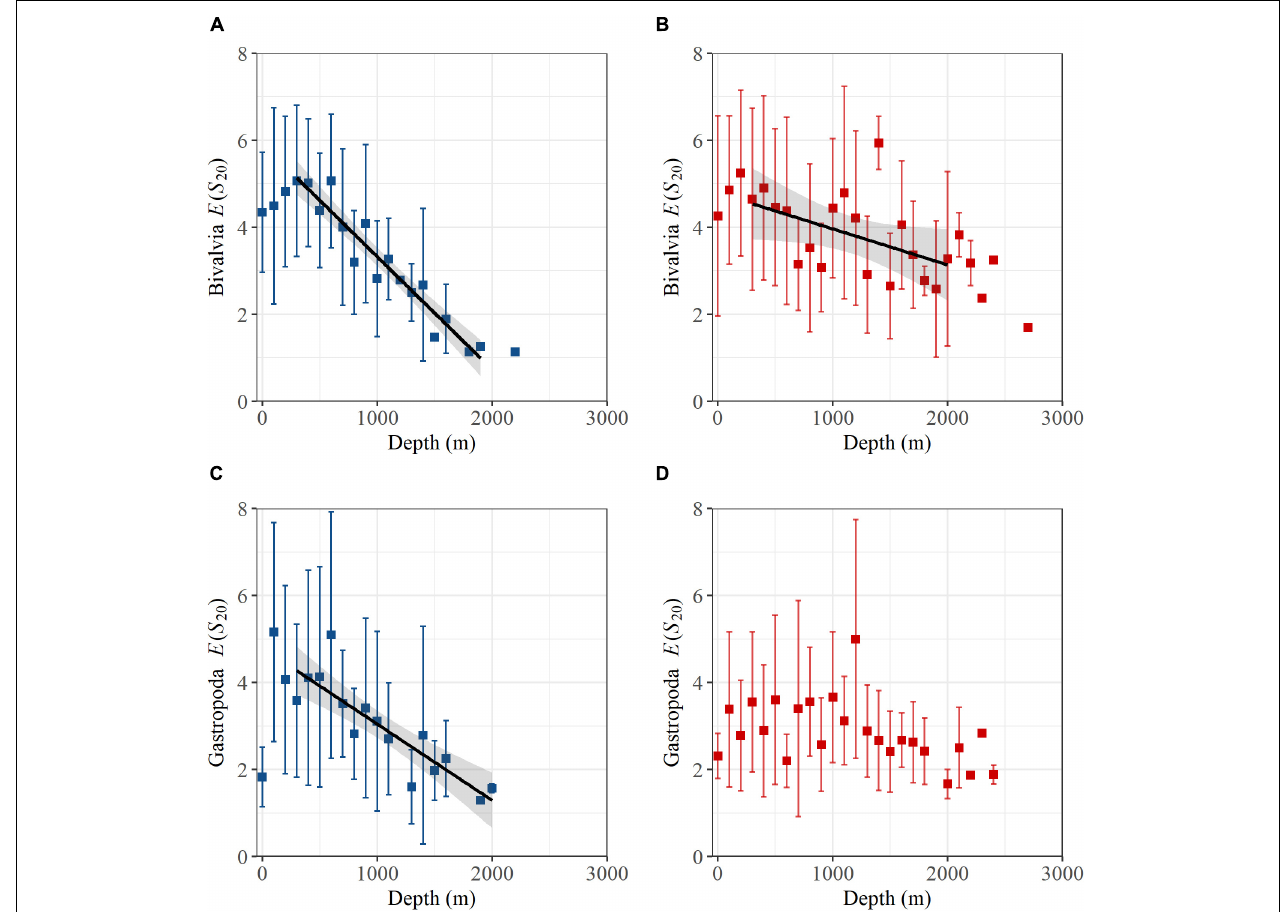
FIGURE 3 | Hurlbert-Sanders expected number of species in a sample of 20 individuals, E ( S 20 ), for (A) bivalves north of the GIF ridge, (B) bivalves south of the GIF ridge, (C) gastropods north of the GIF ridge, and (D) gastropods south of the GIF ridge. Rarefied samples were averaged into 100 m depth bins with error bars representing standard deviations. Where only one sample was available for rarefaction there is no error bar shown. Black lines and shaded region are fitted linear regression models and standard error respectively.